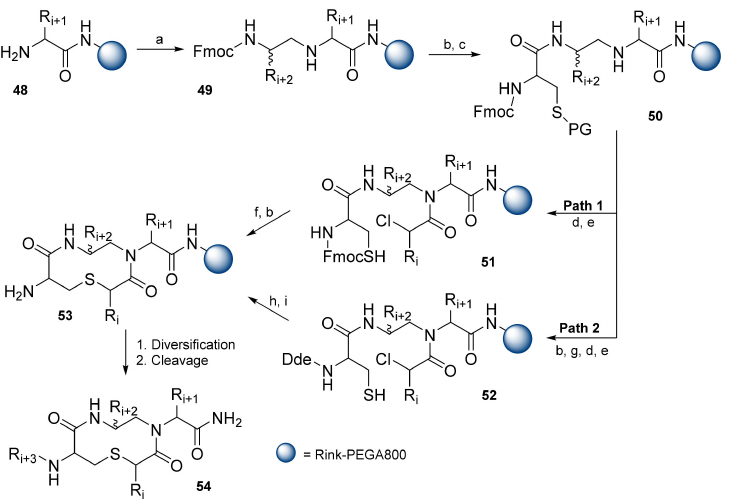
Scheme 9. Reagents and conditions: (a) Fmoc amino aldehyde, NaBH 3 CN, AcOH, DMF; (b) 20% piperidine in DMF; (c) Fmoc-Cys( t Bu)-OH, O -(benzotriazol-1- yl )- N,N,N (cid:48) ,N (cid:48) -tetramethyluronium tetrafluoroborate (TBTU)/NEM, DMF; (d) (ClCH 2 CO) 2 O, NEM, DCM or PhCHClCOCl, DIPEA, DCM; (e) Bu 3 P, H 2 O, THF; (f) NEM, DMF, 55–60 ◦ C, 7 h; (g) 2-acetyldimedone, DMF; (h) DBU,